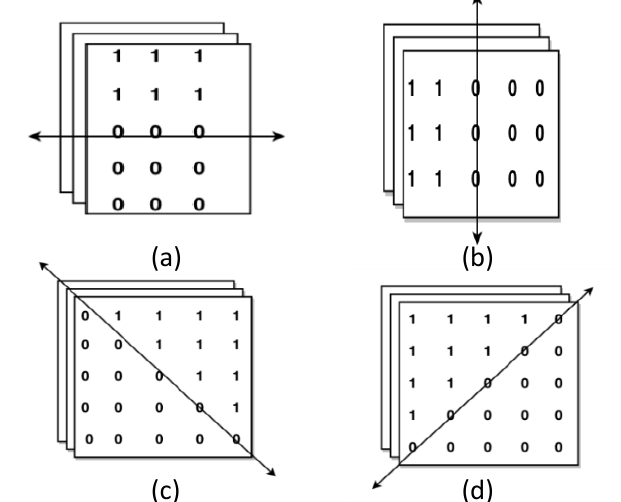
Figure 5. ADT filter coefficients for a three layer-image. Note that the number of layer for ADT filter is the same as those for image to be processed. ( a ) 0 ◦ in horizontal direction, ( b ) 90 ◦ in vertical direction, ( c ) − 45 ◦ and ( d ) 45 ◦ in diagonal